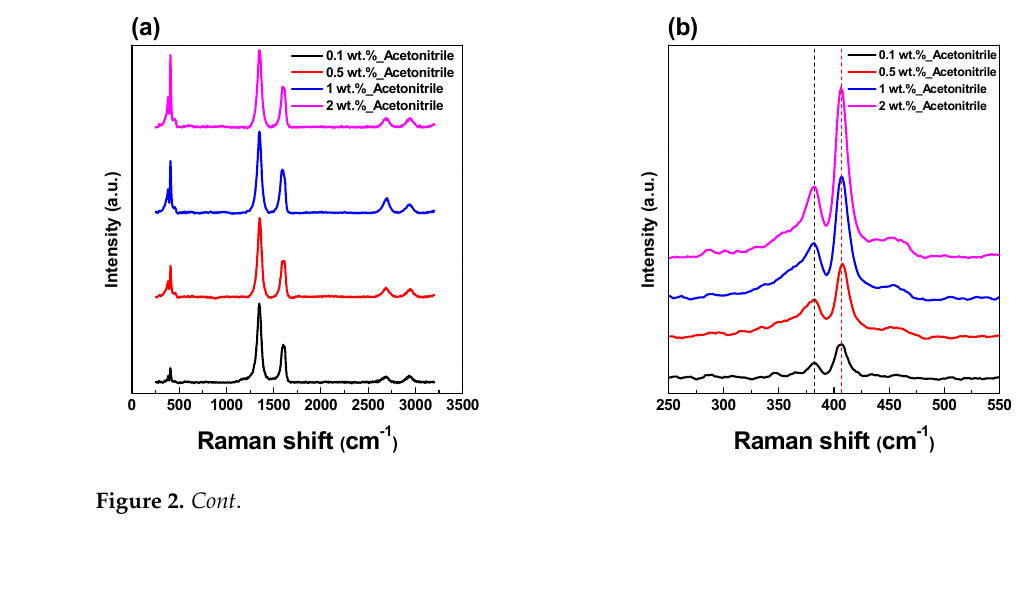
Figure 1. Top view images of the ( a ) pristine carbon nanowall (CNW), ( b ) 500 °C heat-treated ammonium tetrathiomolybdate (ATTM) under hydrogen atmosphere, ( c ) dimethylformamide (DM)– CNW ( × 50,000), ( d ) DM–CNW ( × 100,000), ( e ) acetonitrile (AM)–CNW ( × 50,000), ( f ) and AM–CNW 09 ( × 100,000).